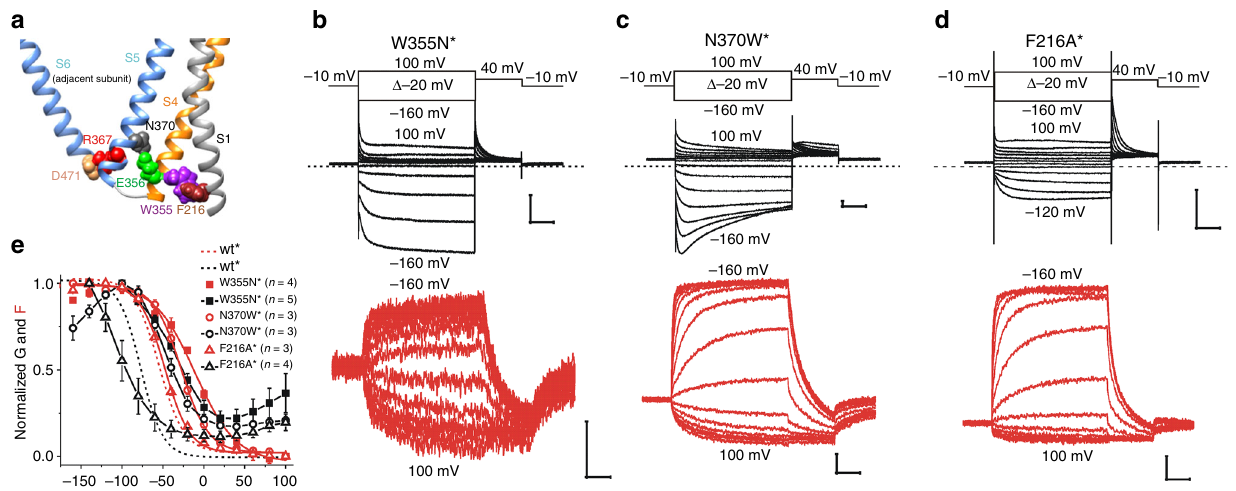
Fig. 2 W355N*, N370W*, and F216A* single mutants do not close at positive voltages. a spHCN homology model showing the position of W355, N370, and F216 with a closed gate and S4 up. b – d Representative current (black) and fl uorescence (red) from b W355N * , c N370W * , and d F216A* channels. Scale bars: 0.1 s, 1 µ A, and 1% Δ F/F . e Normalized G(V) and F(V) curves of W355N * , N370W * , and F216A* channels. G(V) and F(V) of wt * channels are shown for comparison (dashed lines). Mean± SEM. Source data are provided as a Source Data fi